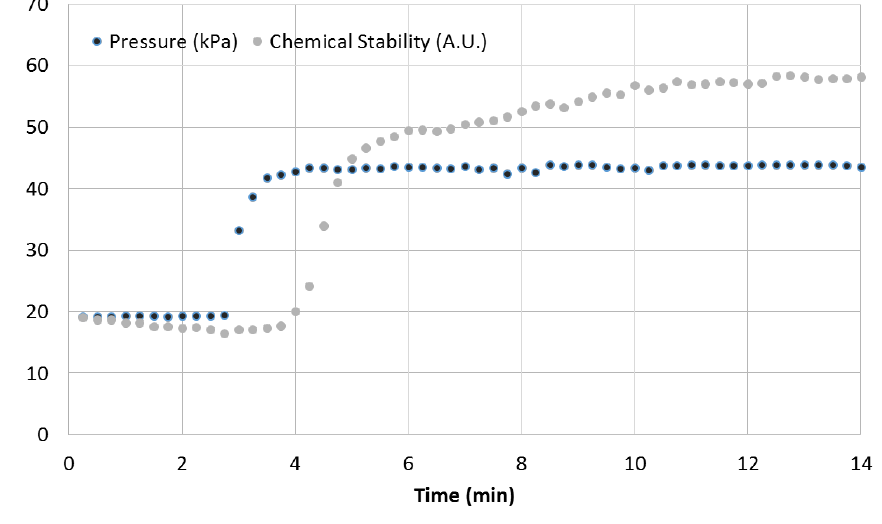
Table 1. Chemical yield in % product of acetophenone, determined by off-line HPLC. Flow Rate